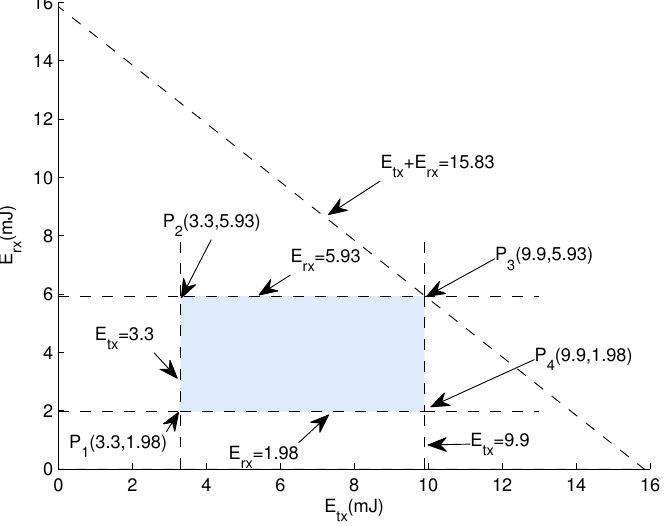
Figure 7. Energy Consumption Feasible